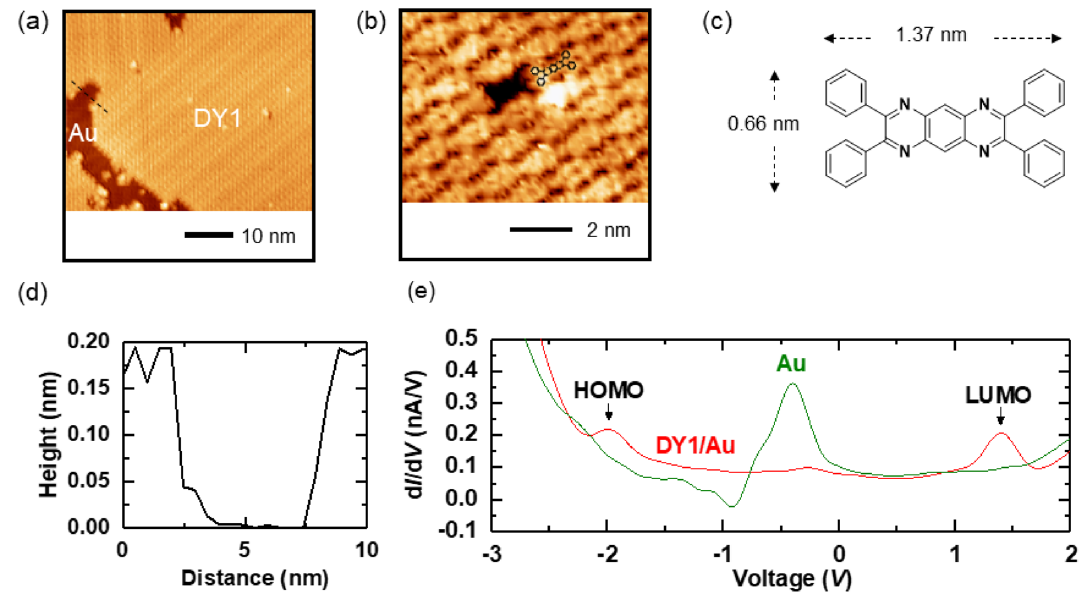
Figure 1. STM topographic images of monolayer DY1/Au(111) obtained at ( a ) V = 1 V and I = 20 pA and ( b ) V = 20 mV and I = 150 pA. The calculated molecular structure in ( c ) is inserted and superimposed near the single vacancy of the molecular layer. ( c ) DFT calculated structure of single DY1 molecule. ( d ) Height profile across the large molecular domain and the exposed Au surface (the black dashed line in ( a )). ( e ) d I / d V spectroscopy results of DY1/Au(111) and Au(111) taken at V = 1.4 V, I = 100 pA and V = 1 V, I = 70 pA, respectively, at a temperature of ~ 10 K. Each result was averaged and smoothed from more than 30